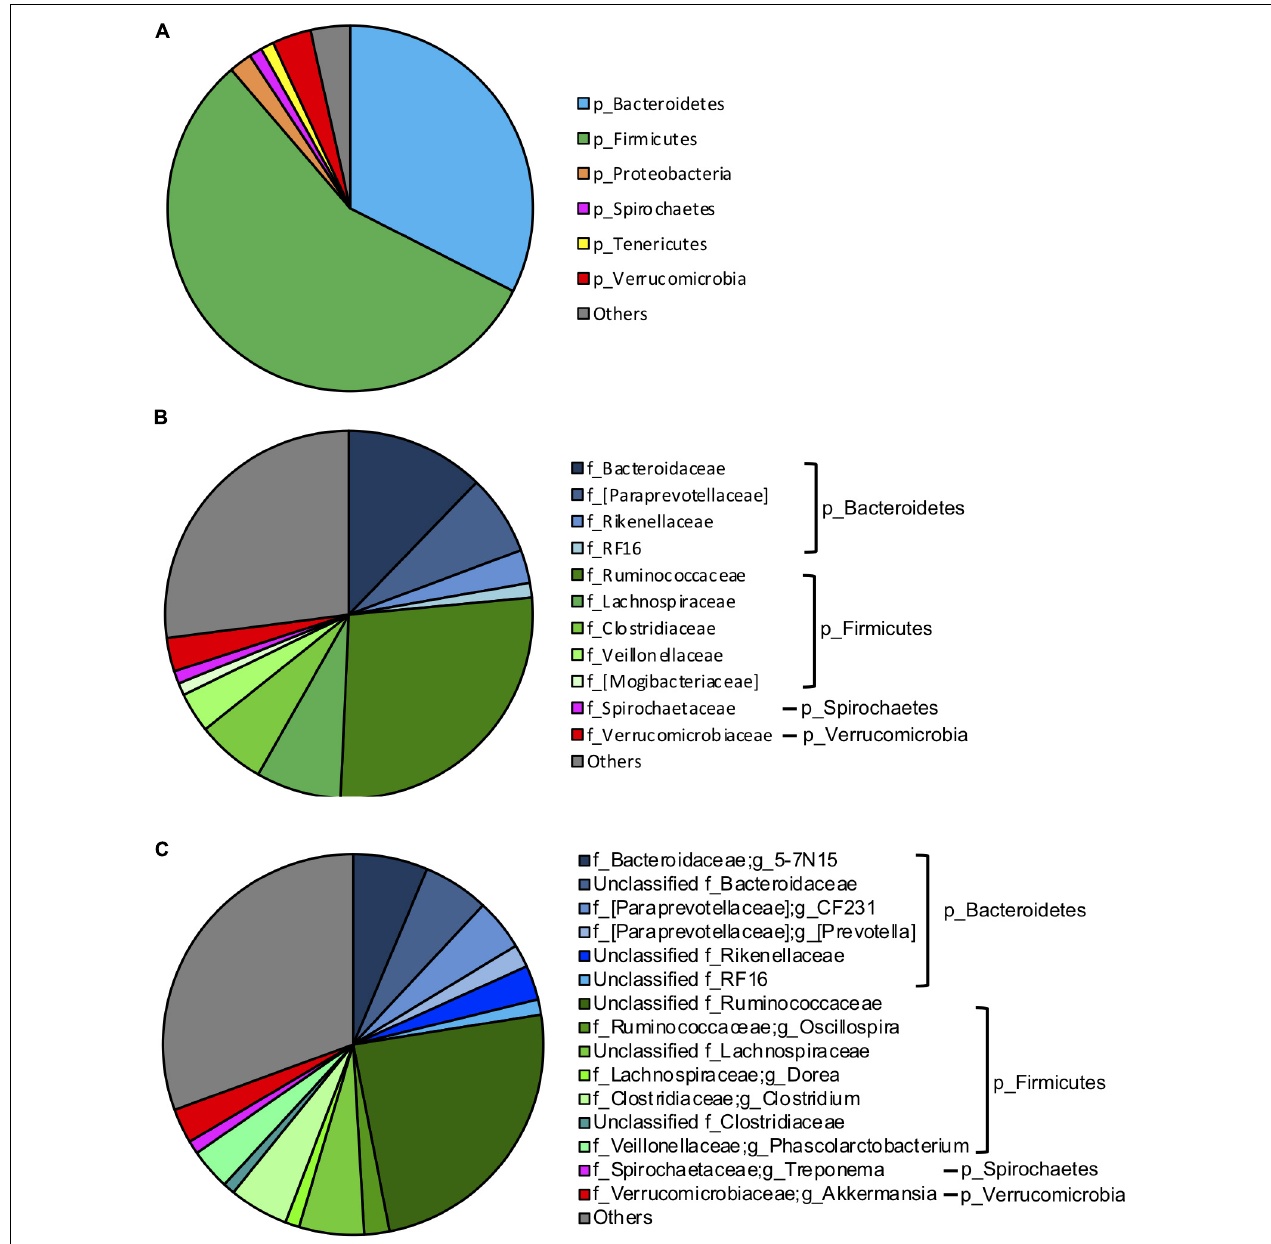
FIGURE 3 | Gut microbiota composition of the MAB postweaning heifers. The dominant (1% of the total bacterial community) phyla (A) , families (B) and genera (C) in the 95 fecal samples of the postweaning